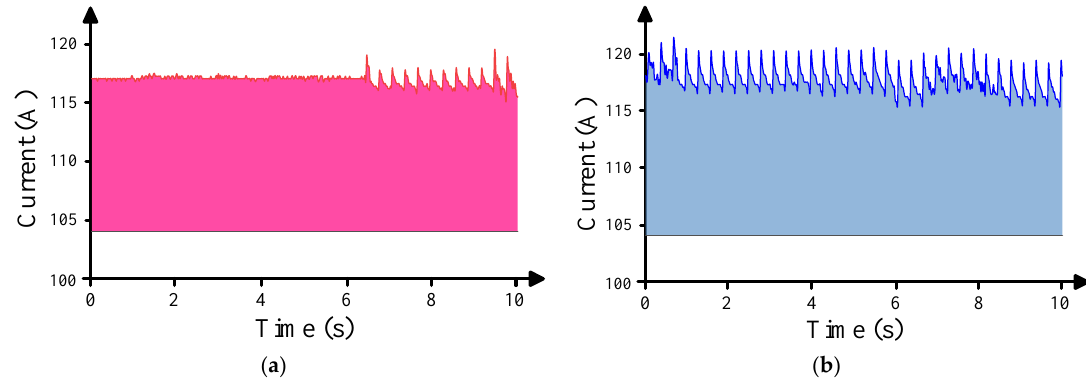
Figure 9. The output waveform disturbed distortion of the ECT acquisition card under 2 kV/100 kHz EFT/Bs: ( a ) Grounding configuration 1 (chassis floating). ( b ) Grounding configuration 2 (chassis grounding).